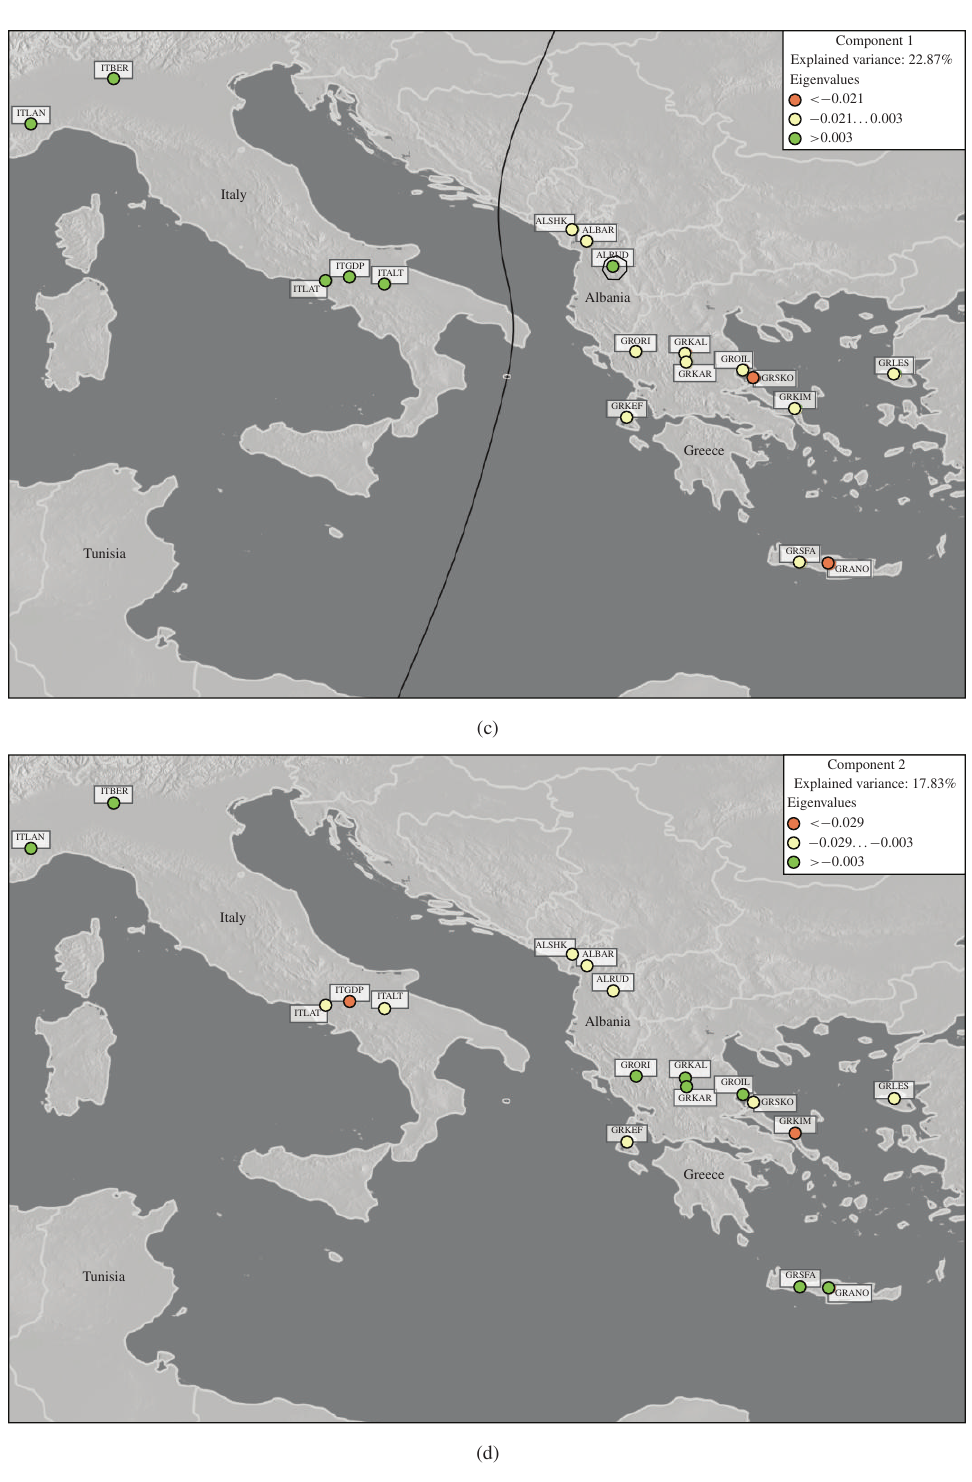
FIGURE 3: First (a) and second (b) components of eigenvectors spatial distribution calculated on mtDNA marker and first (c) and second (d) components calculated on SNPs markers. Background image is GTOPO30, a global digital elevation model (DEM) with a horizontal grid spacing of 30 arc sec-onds (approximately 1 kilometer) produced by the U.S. Geological Survey’s Center for Earth Resources Obser- vation and Science (EROS). The line in the map (c) shows the isoline for an eigenvalue of 0. It appears on panel C only because this is the only geographical configuration for which a limit is so obvious. The circle around the RUDA breed shows an isoline for the eigenvalue of